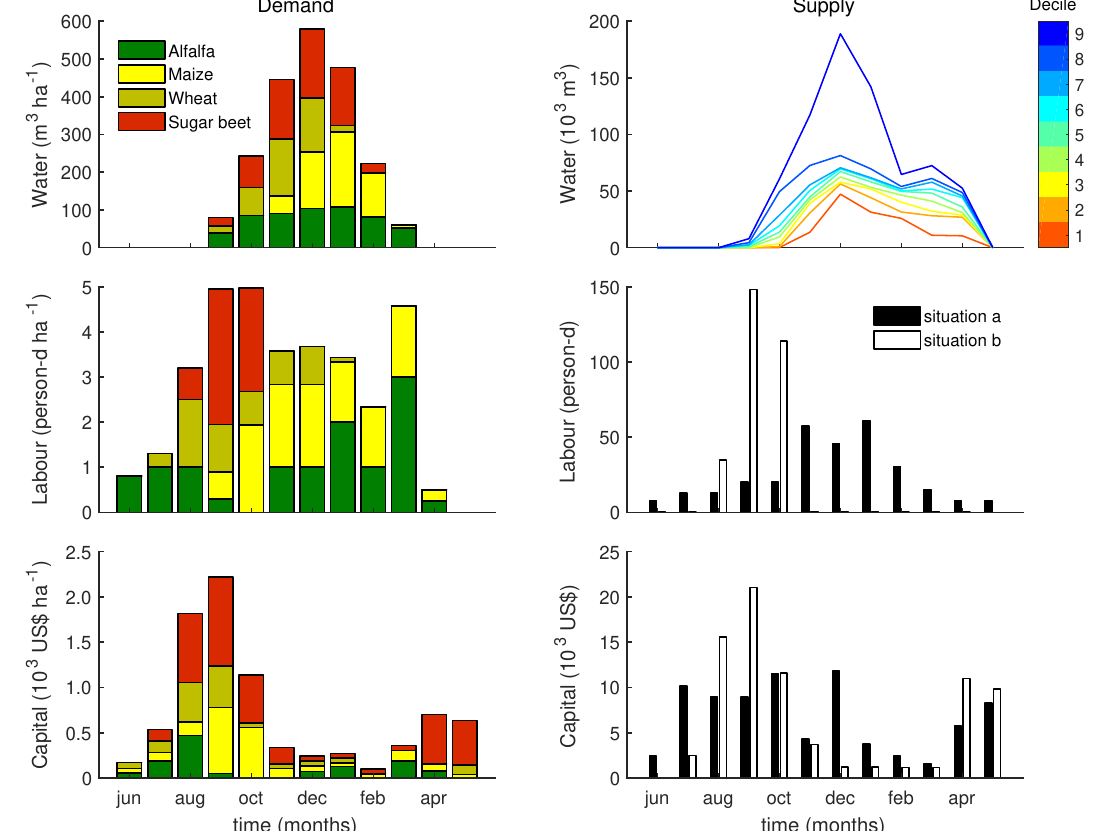
Figure 3. Monthly demand and supply of resources using collated data. Deciles 1 and 9 are the driest and the wettest conditions, respectively. Distribution of labour and capital are provided by the situation a (black bar) and b (white bar). Seasonal amount of labour and capital availability is 300 person-day and 80,000 US$, respectively. See ODEPA [46], ODEPA [47], and INIA [45] for more detailed sources of